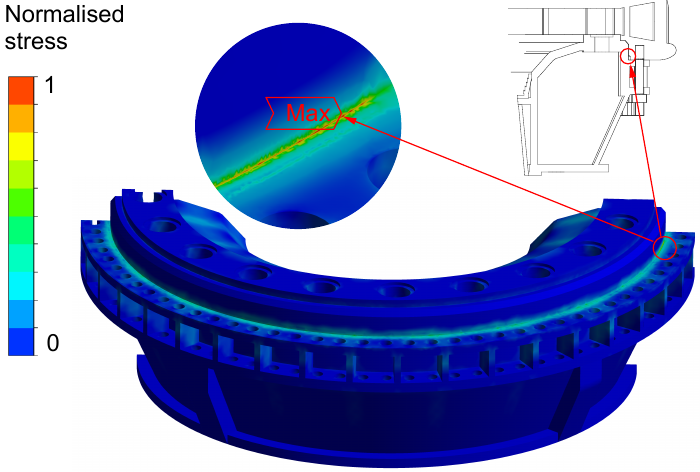
Figure 21. The stress distribution of the bottom ring. The von Mises stress distributions of the stationary structures at different time points during load rejection are similar and the hot spots of the stationary structures appear in the same locations of the head cover, stay ring and bottom ring, but the maximum stress value change with time. Figure 22 shows the stress comparison of the normalized stresses of the stationary structures during load rejection. All stresses are normalized with reference to the maximum stress of the stay ring, which is larger than the maximum stresses of the head cover and the bottom